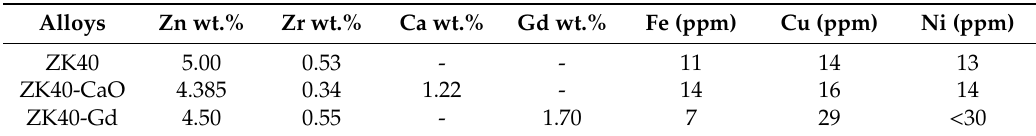
Table 1. Chemical compositions of the investigated alloys measured with X-ray fluorescence (Gd and Ca) and spark analyser (Zn, Cu, Fe, Ni,